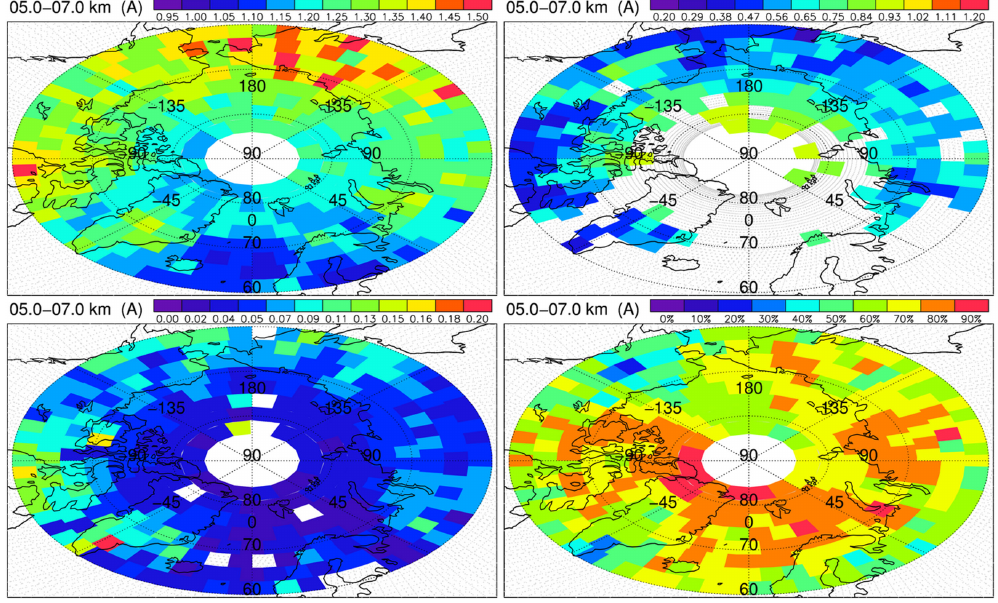
Figure 14. Map of the 532nm backscatter ratio (top left), aerosol colour ratio (top right), pseudo-depolarization ratio (bottom left) and fraction of cloudless observations (bottom right) using the April 2008 filtered level 1 CALIOP data in the 5–7km altitude range. Colour scales are in relative units.